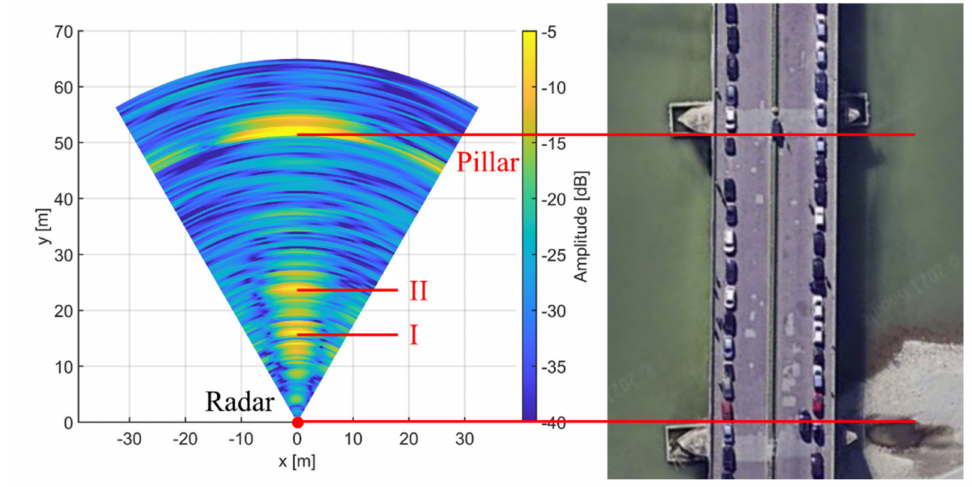
Figure 20. Radar image of Vespucci bridge focused using the MIMO system.